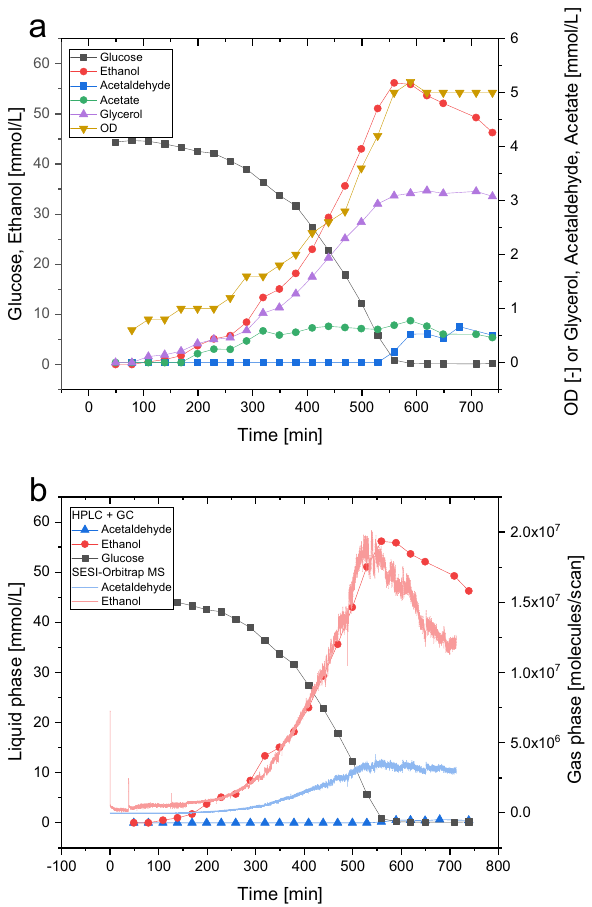
Figure 3. Results of the 200 mL scale yeast fermentation with online SESI-Orbitrap MS-based off-gas analytics. Optical density and common metabolites (measured by HPLC and GC) ( a ), agreement of the ethanol and acetaldehyde concentrations measured by HPLC and GC or SESI-Orbitrap MS ( b